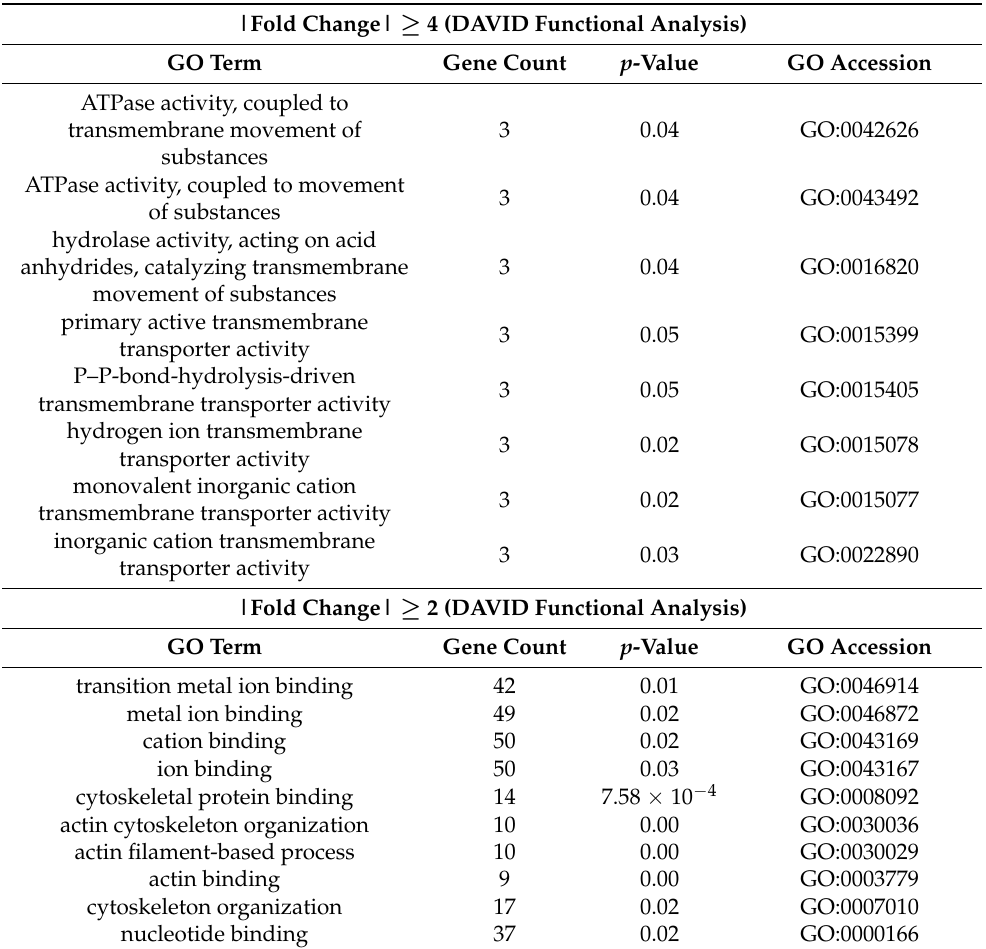
Table 4. Molecular function groups identified by the functional annotation clustering analysis with |fold change| ≥ 4 and 2 (DAVID functional